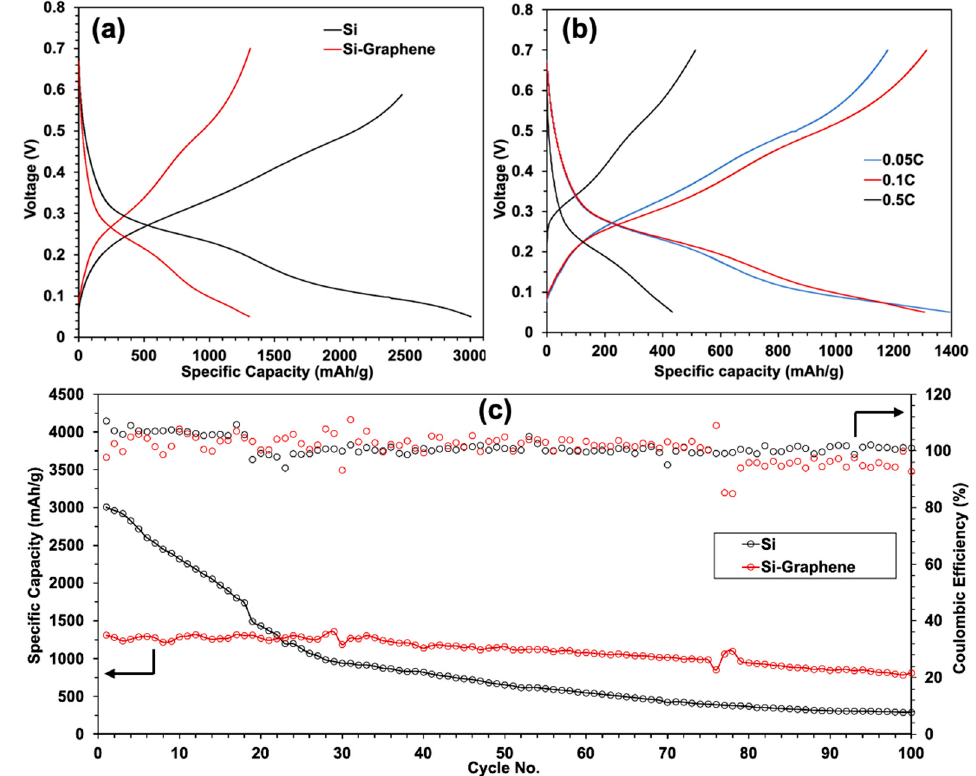
Figure 5. ( a ) Specific charge/discharge capacity of Si-graphene and Si anodes at 0.05C; ( b ) specific charge/discharge capacity of Si-graphene anode at 0.05C, 0.1C, and 0.5C, respectively; ( c ) specific charge/discharge cycling performance of Si-graphene and Si anodes at a current rate of 0.1C in the first 100 cycles.